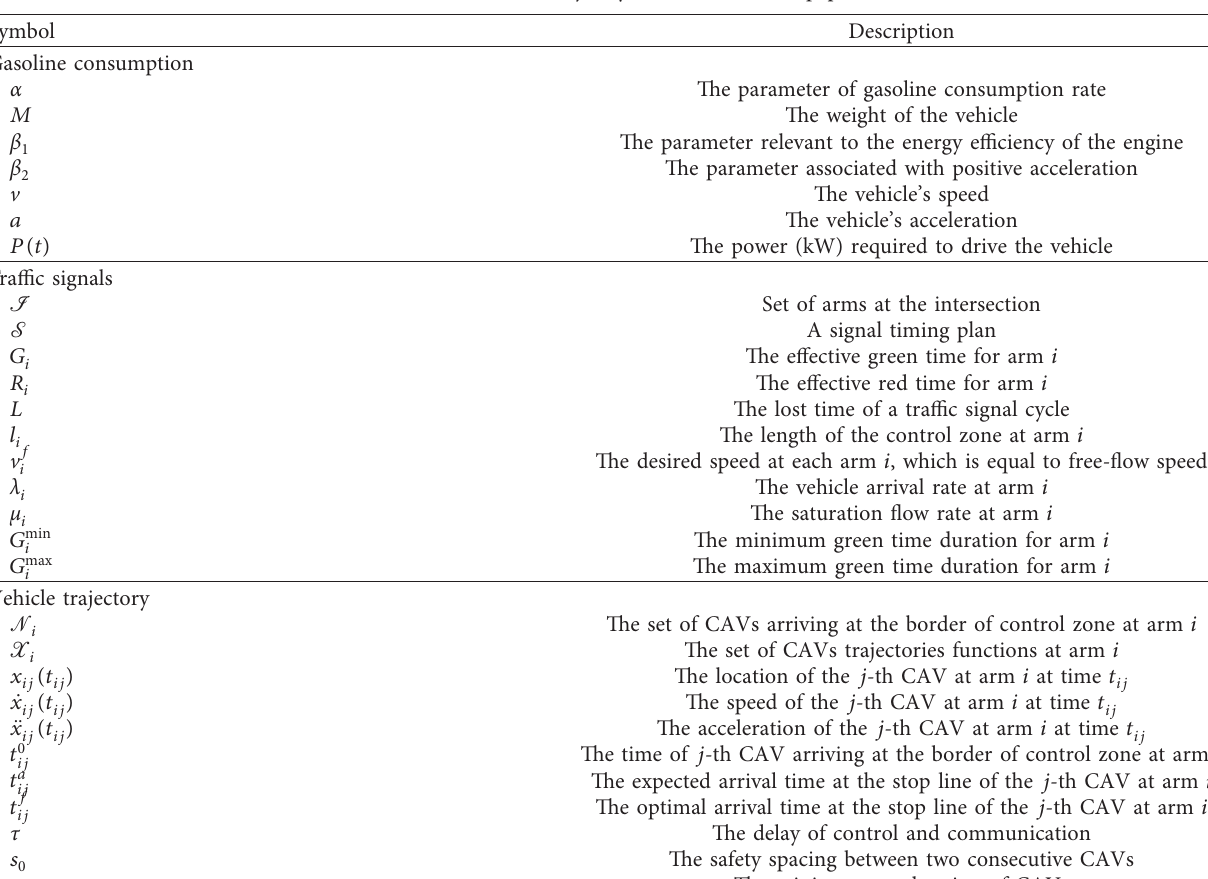
Table 1: Notation of major symbols used in this